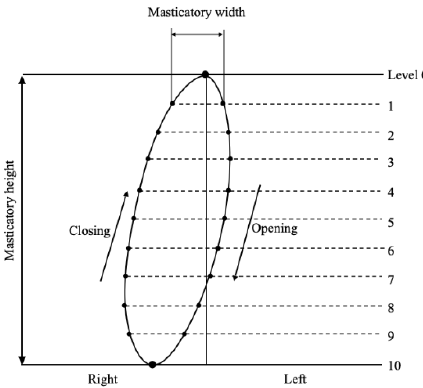
Figure 6. Measurement of the masticatory width and height. With an intercuspal position of 0 and a mean maximum mouth opening position of 10, the opening and closing path distances of the mouth were measured at levels from 1 to 9. The mean value was calculated and used as the masticatory width.